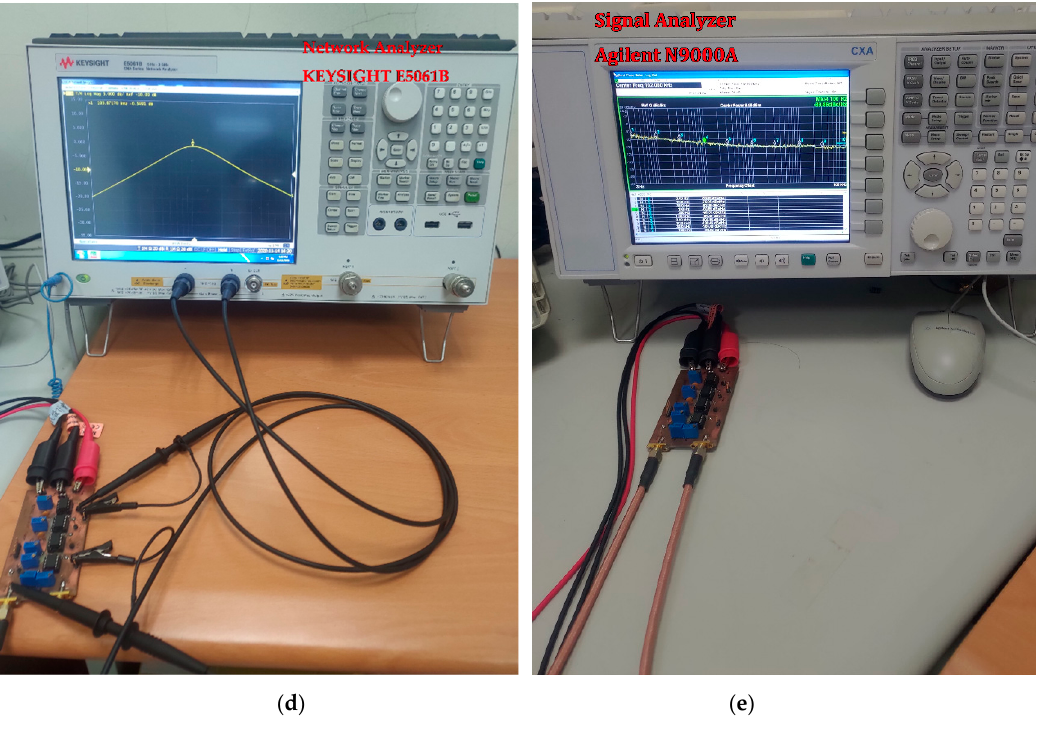
Figure 5. Experimental setup. ( a ) Test setup block diagram; ( b ) the top and bottom of the measured prototype; ( c ) Tektronix DPO 2048B oscilloscope for measuring time domain voltage output, Tektronix AFG1022 signal generator for generating input signal, and Keithley 2231A-30-3 for power supply; ( d ) Keysight E5061B-3L5 network analyzer for measuring frequency domain filter responses; and ( e ) Keysight-Agilent N9000A CXA signal analyzer for measuring filter and oscillator output spectrum.